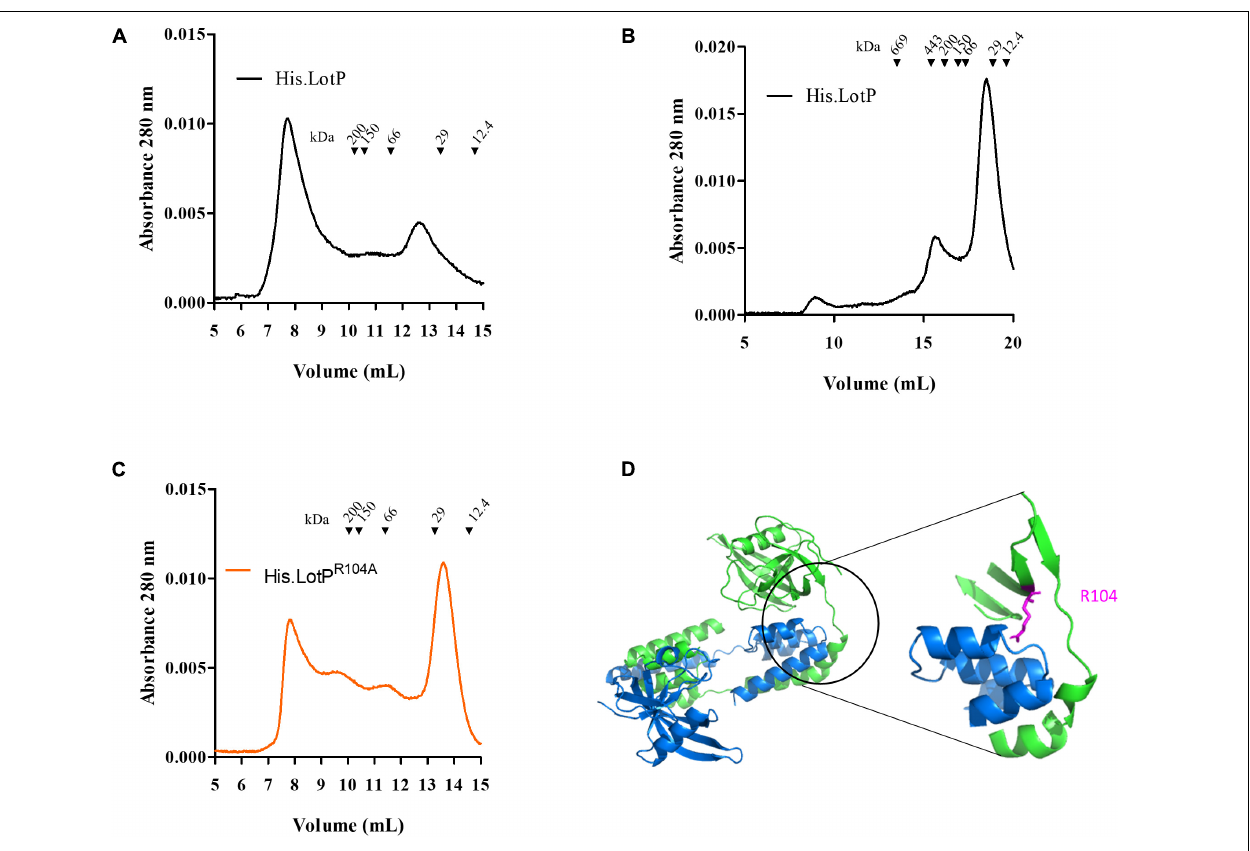
FIGURE 1 | Equilibrium of LotP dimers—oligomers and the contribution of conserved amino acids in LotP folding. Representative chromatograms of purified His.LotP analyzed by size-exclusion chromatography using a Superose 12 column (A) and Superose 6 column (B) . (C) Representative chromatograms of purified and His.LotP R104A analyzed by size-exclusion chromatography using a Superose 12 column. The purified proteins were separated according to its native molecular size with the varying oligomers. Elutions were monitored continuously at 280 nm, and the graphics represent the signal at the different elution volumes. (D) LotP dimer structure modeled with GalaxyWEB sever using the crystal structure of Bacillus subtilis Lon N-terminal domain (PDB: 3M65A) as template. The leading model is a dimer with a prediction score of 305.854 and structural similarity of 0.9547. The inset of the dimer structure shows the mutated residue R104 in